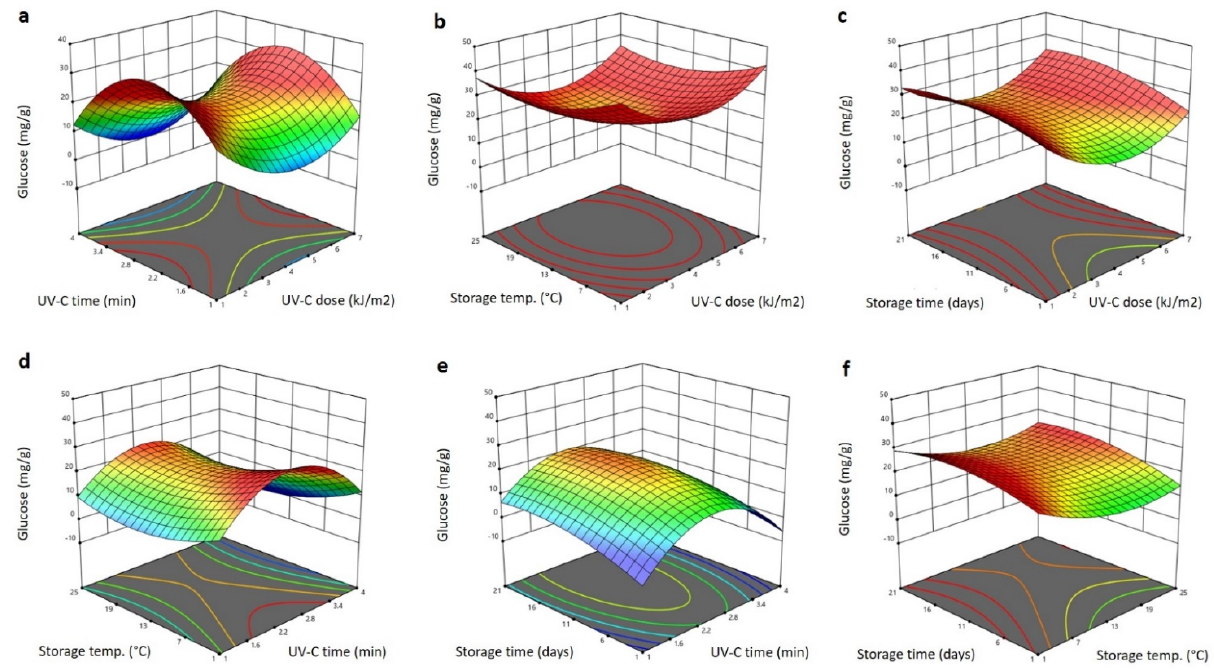
Figure 8. Response surface plots of glucose content of Barhi dates as a function of UV-C time and UV-C dose ( a ), storage temperature and UV-C dose ( b ), storage time and UV-C dose ( c ), storage temperature and UV-C time ( d ), storage time and UV-C time ( e ), and storage time and storage temperature ( f ).